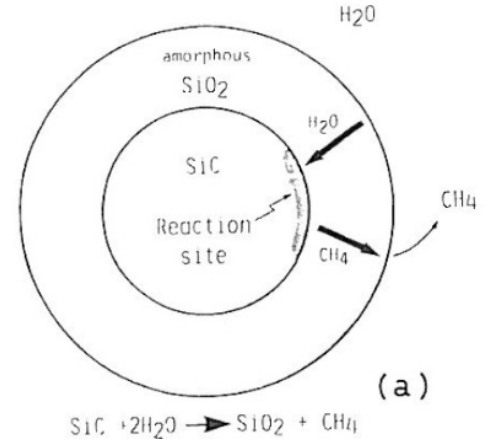
Figure 25. Reaction model of the hydrothermal oxidation of SiC powder. Reprinted with permission from Reference [92]. Copyright 1986 Materials Research Society.